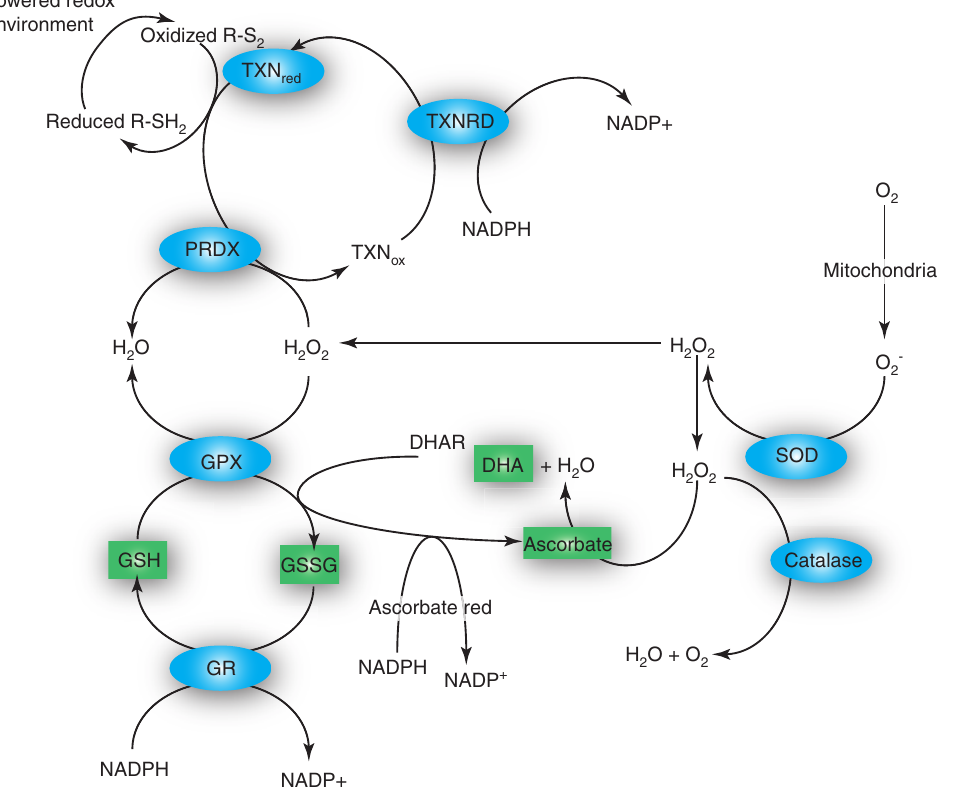
Figure 2: Intracellular antioxidant enzymes critical to the maintenance of muscle and cardiac